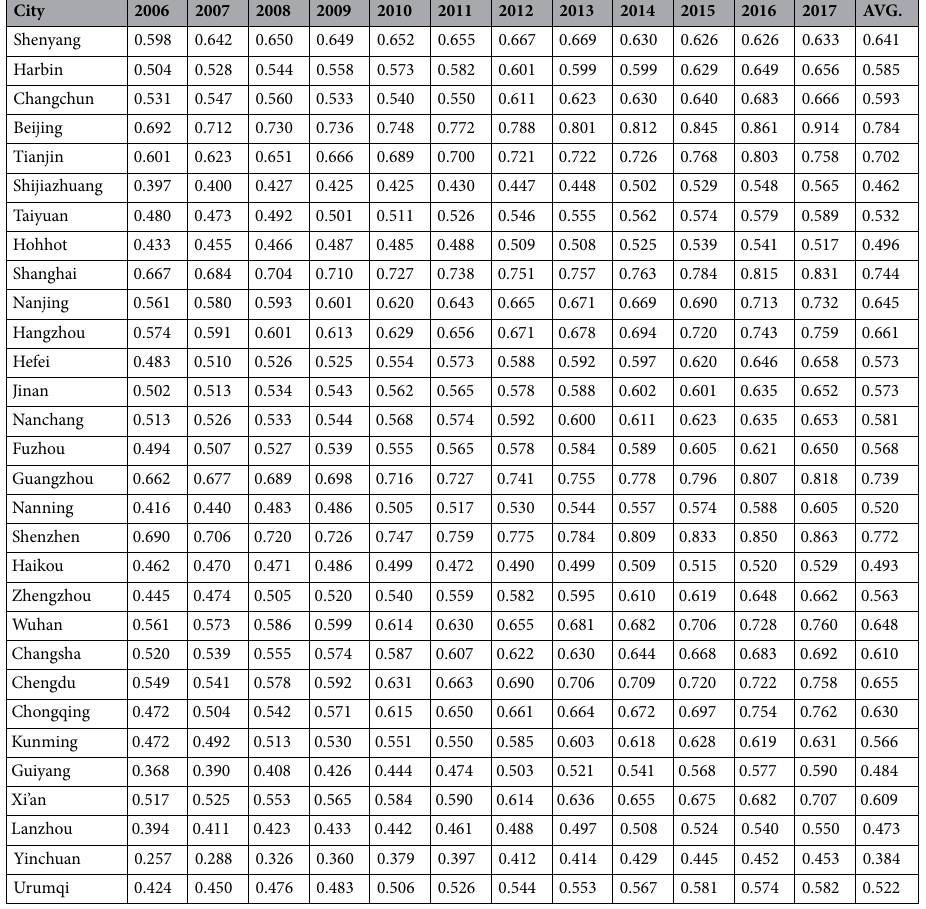
Table 4. CCD of low-carbon-economic-environment index from 2006 to